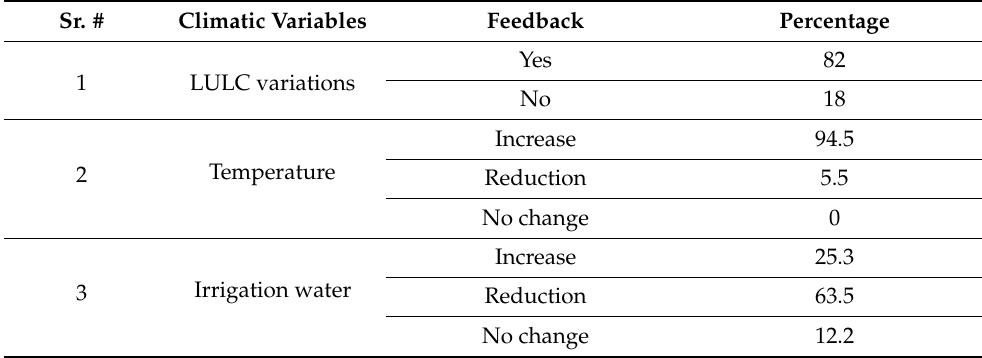
Table 2. Farmers’ feedback about climatic and LULC variations.